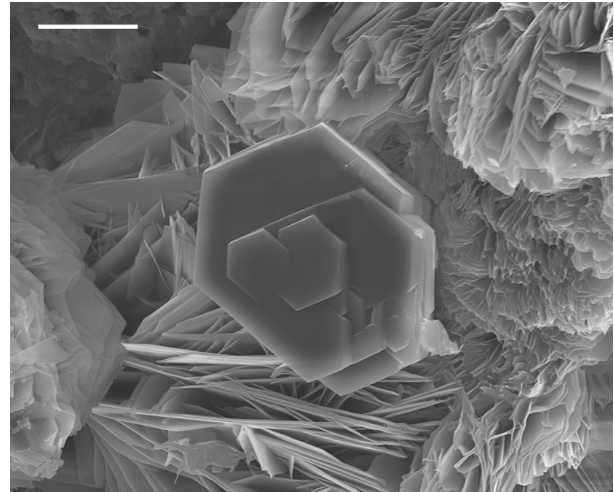
Figure 4. Scanning electron microscope image showing hexagonal crystals of tomsquarryite associated with penriceite in Tom’s quarry specimen G35033. Scale bar is